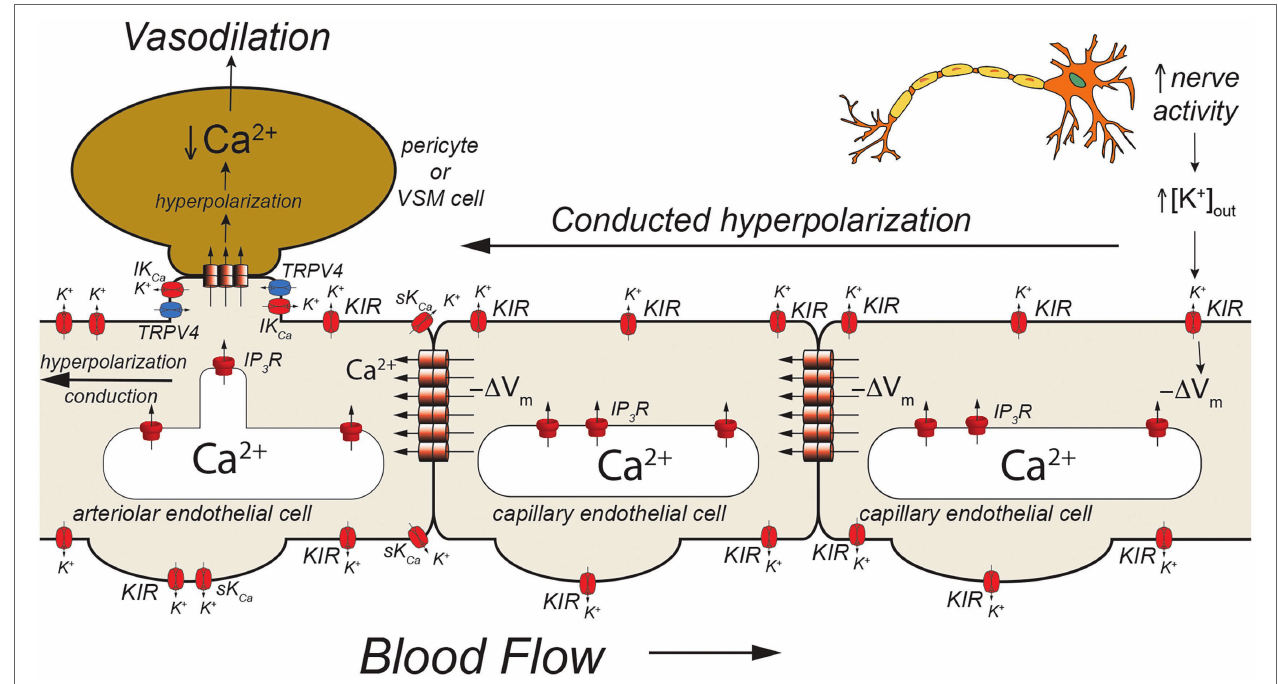
FIGURE 3 | Capillaries as sensors of [K + ] out . Schematic of a capillary segment that transitions to a vessel invested with contractile pericytes (initial capillary segment) or smooth muscle cells (terminal arteriole). Active neurons release K + during action potential repolarization. This increases [K + ] out which is sensed by K IR 2.1 channels (KIR). Movement of K + out of activated K IR 2.1 channels results in membrane hyperpolarization ( −Δ V m ). The local membrane hyperpolarization activates adjacent K IR 2.1 channels allowing this hyperpolarization to be conducted from the site of initiation through homocellular gap junctions from endothelial cell-to-endothelial cell back toward the initial capillary segment (invested with contractile pericytes) and the terminal arteriole (with smooth muscle cells). These contractile mural cells are coupled to underlying endothelial cells by heterocellular gap junctions which allow transmission of the hyperpolarization to the contractile cells. In smooth muscle cells (and presumably contractile pericytes), the hyperpolarization will deactivate voltage-gated Ca 2+ channels, decreasing [Ca 2+ ] in and leading to smooth muscle (or pericyte) relaxation and vasodilation. Dilation of the terminal arteriole (or the initial capillary segment) will result in an increase in blood flow to the microvascular unit, directing blood flow to the site of increased neural